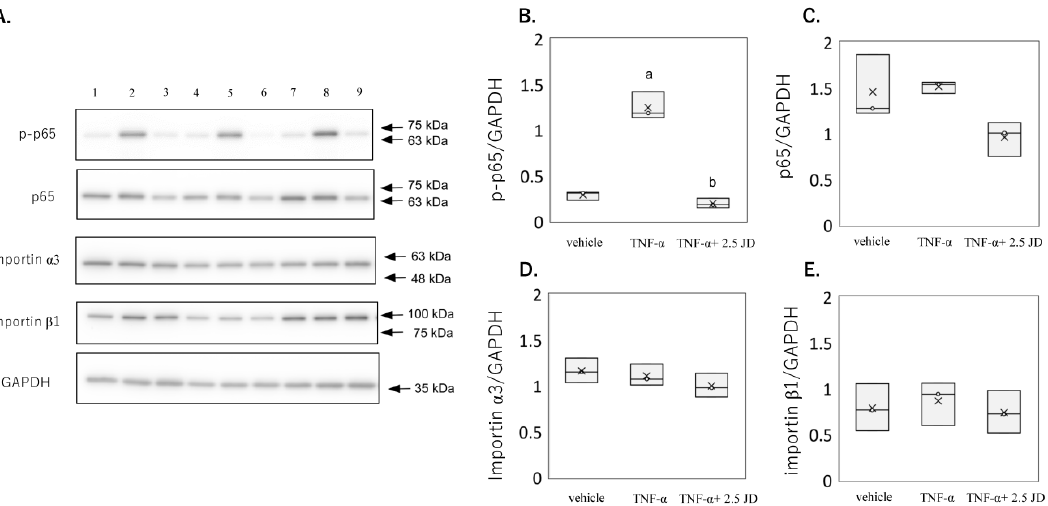
Figure 5. Effect of jietacin derivative on the NF- κB pathway in human primary synovial fibroblasts . Western blotting for p65, phosphorylated p65 (p- p65), importin α3, importin β1 , and GAPDH ( A ). Densitometry of Western blot protein bands for p-p65 ( B ), p65 ( C ), importin α3 ( D ), and importin β1 ( E ) were normalized to the expression of GAPDH ( n = 3). Vehicle, Lane 1,4,7; TNF- α, Lane 2,5,8; TNF- α + 2.5 JD Lane 3,6,9. a p < 0.05 compared with vehicle, b p < 0.05 compared to TNF- α. The mammalian NF- κ B subfamily comprises five proteins, namely, p50 (NF- κ B), p52 (NF- κ B2), p65 (RelA), RelB, and c-Rel [22]. NF- κ B is retained in the cytosol in an inactive state under normal conditions, bound to the inhibitory protein I κ B [28,29]. Any or all of proinflammatory cytokines, matrix degradation enzymes, and excessive mechanical stress can induce a cascade of reactions which lead to the phosphorylation of I κ B and resulting proteasome-system-mediated degradation via the ubiquitin proteasome system. Further, I κ B degradation then leads to the release of active NF- κ B, which is translocated to the nucleus where it induces gene transcription [28]. We previously reported that JD inhibits this translocation to the nuclei, and that its inhibitory effect is lost in cells having